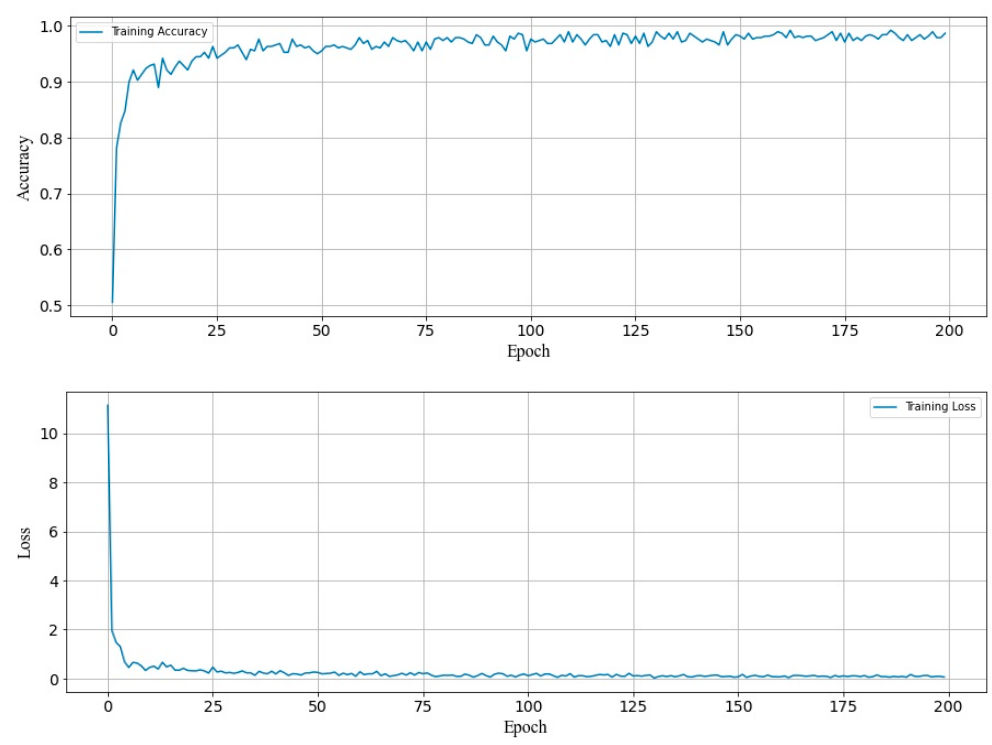
Figure 15. Accuracy and loss after training 200 times.